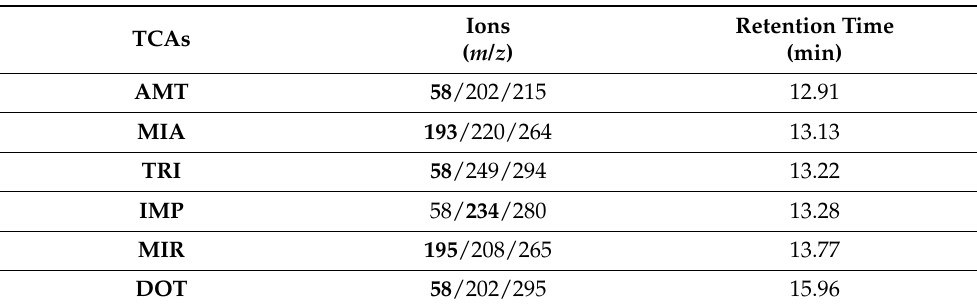
Table 1. Target ions (base peaks in bold) and quantifier ions for each TCA studied by LVI-GC- MS(SIM), under optimized instrumental conditions.